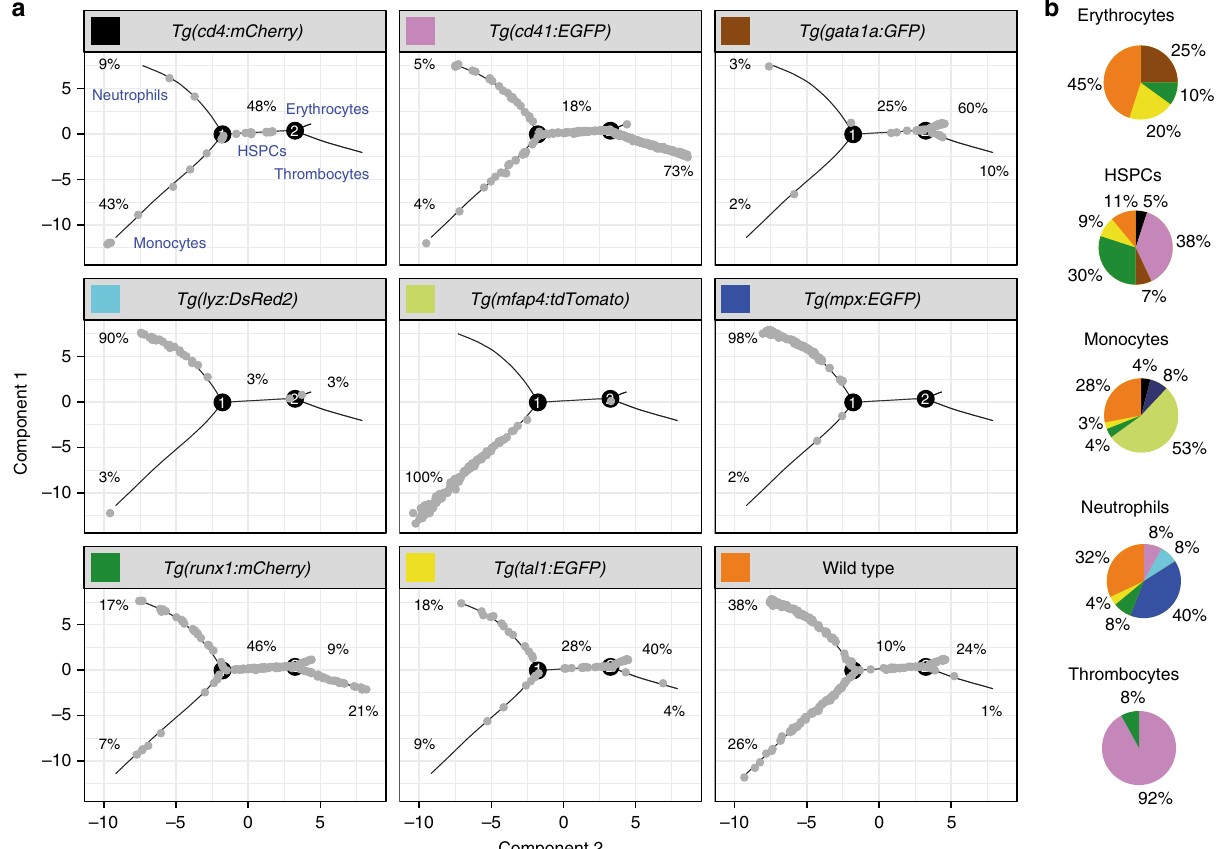
Fig. 2 The distribution of cells from different transgenic lines modelled by Monocle. a The trajectories of cell states predicted by Monocle are shown in grey for each transgenic line used, with the associated cell types labelled in blue. The percentage of cells from each transgenic line contributing to each state is given next to the relevant trajectory. b Pie charts showing the contribution of transgenic lines to each cell type. The colour code relates to the colours given in the headers for each transgenic line used in